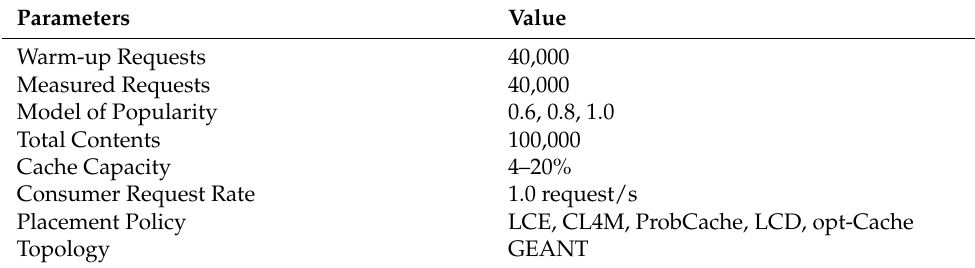
Table 9. Simulation